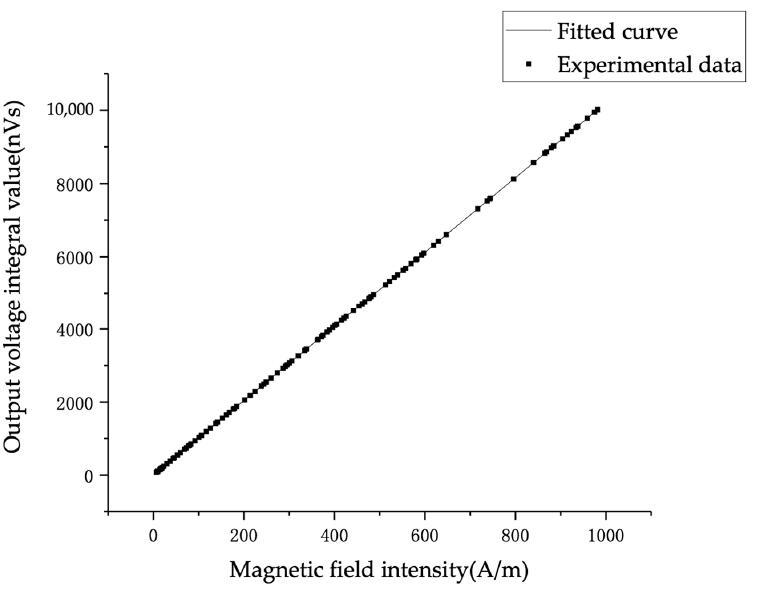
Figure 12. The relationship between the amplitude of the output signal after integrating in the calibration environment and the injected current.